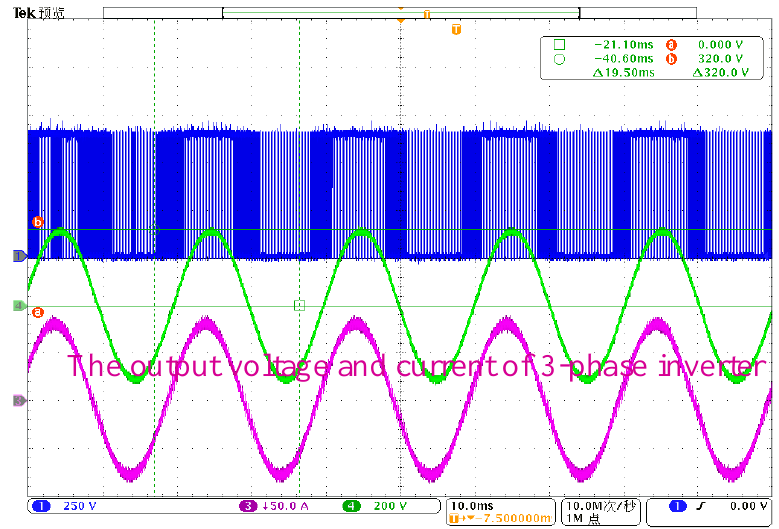
Figure A3. The waveform for three-phase inverter loss.